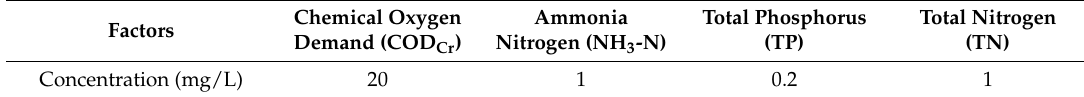
Table 4. Water quality objectives of trans-boundary cross sections.